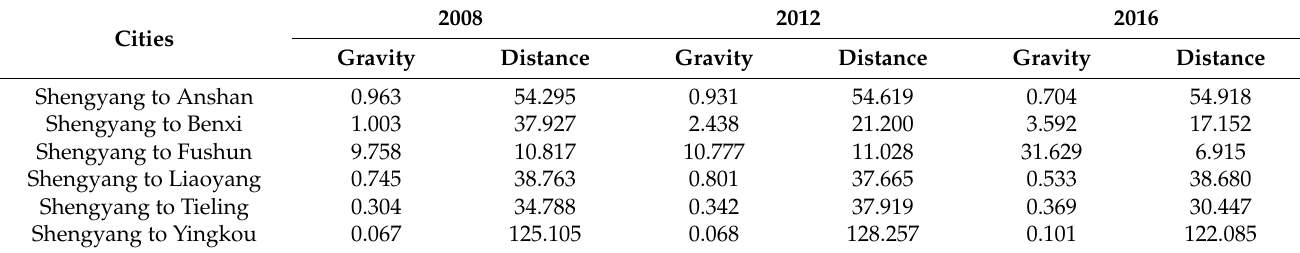
Table 6. The urban gravity and distance between cities in central Liaoning urban agglomeration.